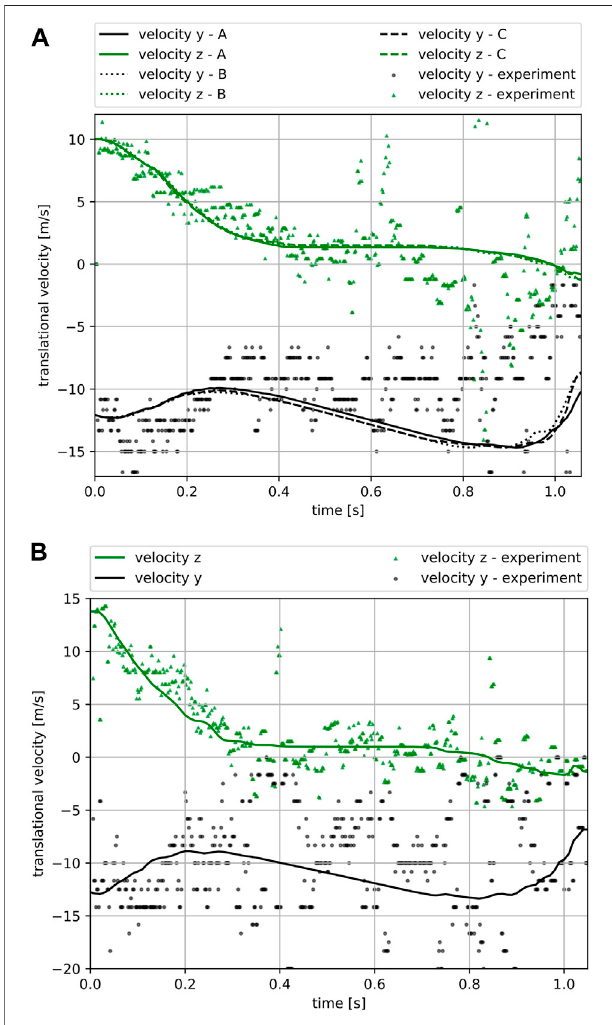
FIGURE 15 | Comparison of translational velocity for both the horizontal direction, z and the vertical in gravity direction, y. (A) The three optimal parameter combinations for T092. (B) T089 with parameter set